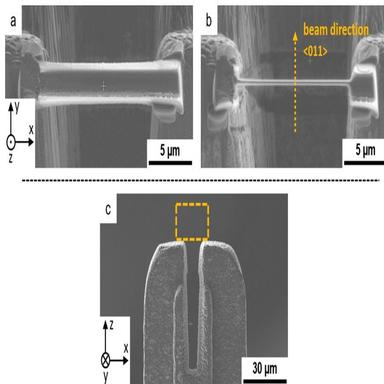
Two-pole specimen preparation by FIB. Top views of (a) the specimen attached to the lift-out grid prior to thinning and (b) of the thinned specimen with remaining solid poles to both sides of the thinned area. (c) Side view of the flattened post of the lift-out grid and milled trench for avoidance of material redeposition during thinning. The later position of the specimen is marked by the orange rectangle. The spatial orientations given in (a) are equally valid for (b).